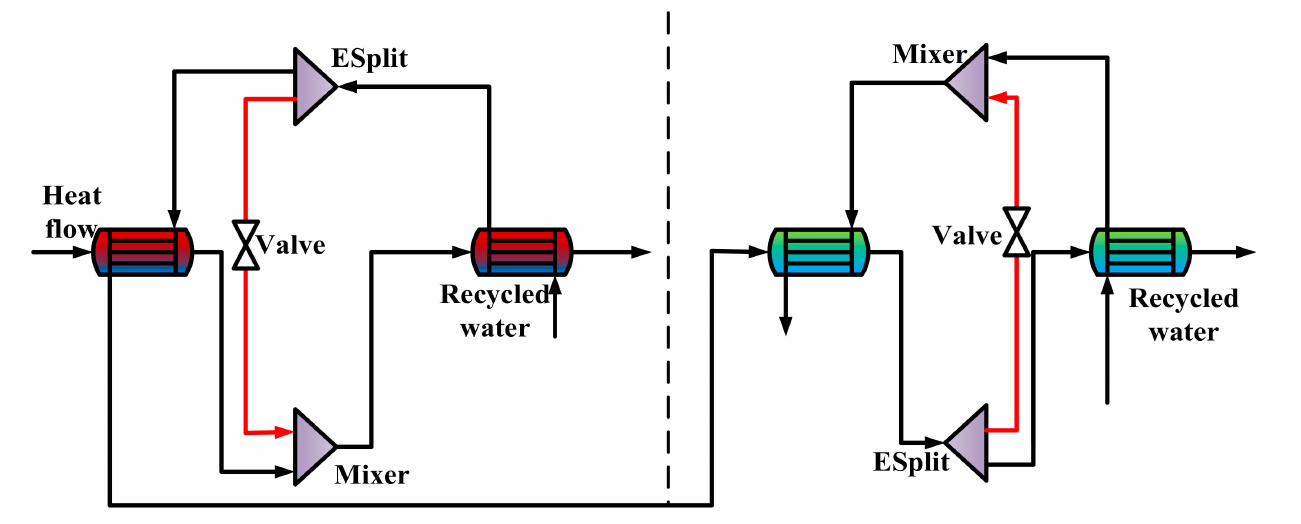
Figure 2. The internal leakage mechanism model of